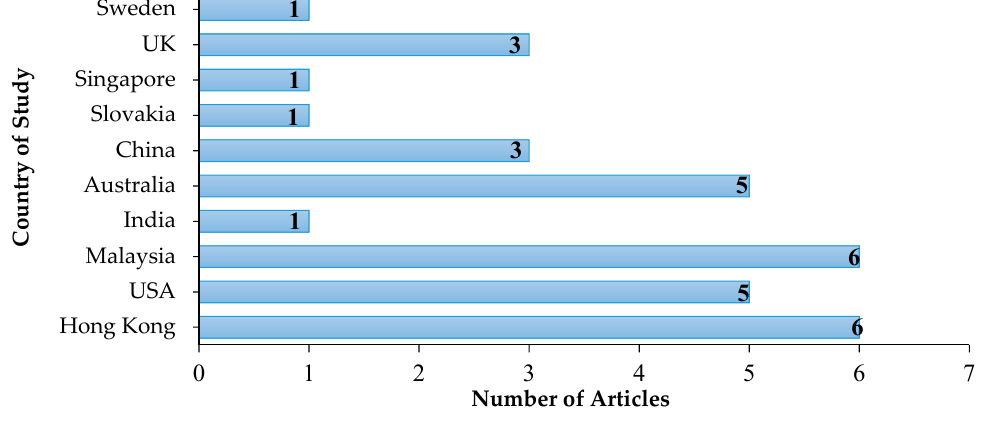
Figure 4. Geospatial distribution of research publications.